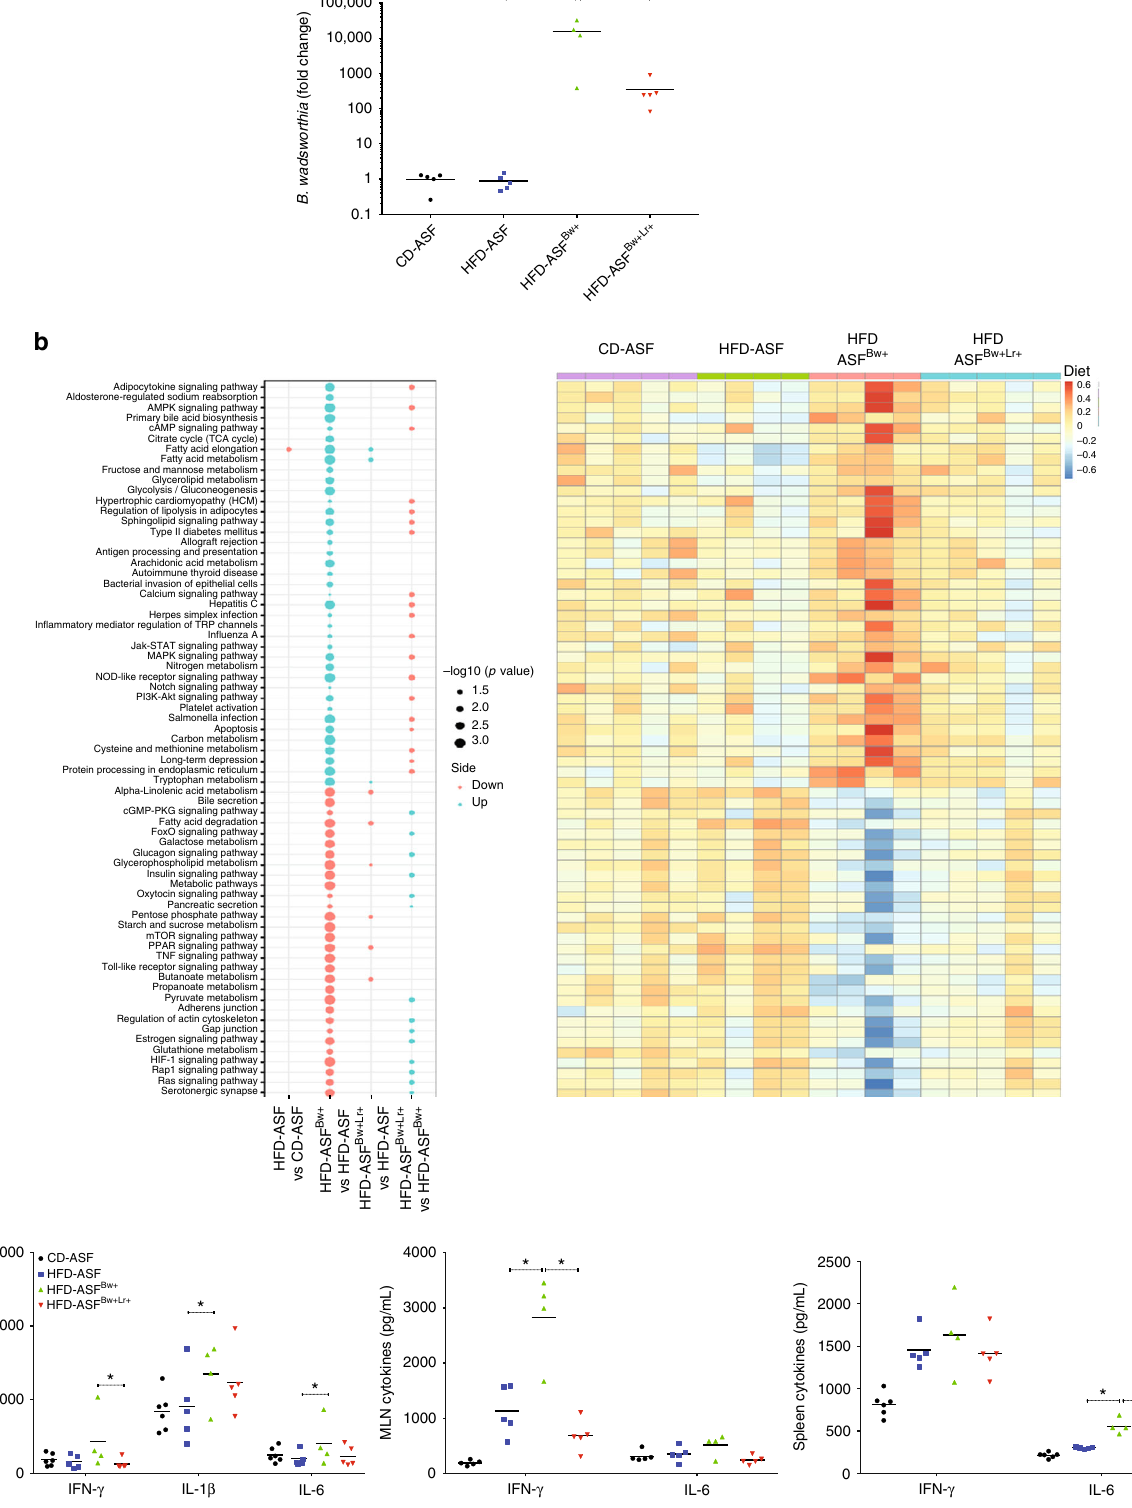
Fig. 4 B. wadsworthia regulates expression of in fl ammatory and metabolic-related host genes under HFD setting. a Fold change of B. wadsworthia (Bw) relative from altered Schaedler fl ora (ASF)-colonized mice fed with control diet (CD). b Left: Bubble plot of -log10(BH p -values) of a selection of signi fi cant pathway activities between indicated groups (Blue: up regulated in fi rst compared to second group. Red: down regulated in fi rst compared to second group); right: Heatmap of corresponding pathway activity. c Cytokine production in caecum, mesenteric lymph node and spleen (* p < 0.05 vs. HFD-ASF, + p < 0.05 vs. HFD-ASF Bw + ; n = 4 – 5/group). Statistical comparison was performed by fi rst testing normality using Kolmogorov – Smirnov test and then ANOVA or Kruskal – Wallis test with Bonferroni or Dunn ’ s post hoc test. Error bars represents